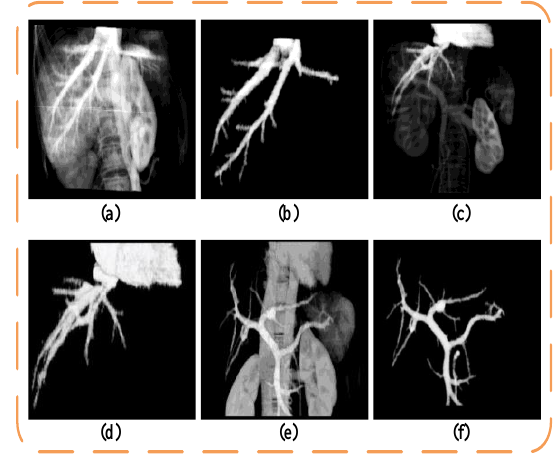
Figure 6. Test results obtained using three datasets